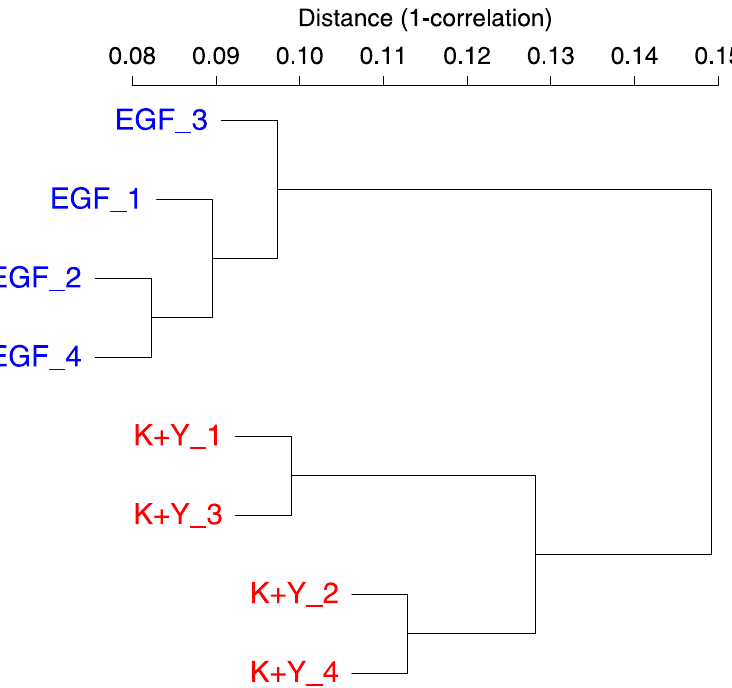
Figure 2. Hierarchical clustering analysis of EGF-treated LECs and K + Y-treated LECs. In total, 31,406 promoters that had more than 10 CAGE tags in at least one sample were examined. Hierarchical clustering analysis was performed using the average linkage algorithm with a Spearman correlation distance matrix. The same numbers correspond to the same donors. LECs in each condition showed a similar expression pattern. K + Y: KGF and